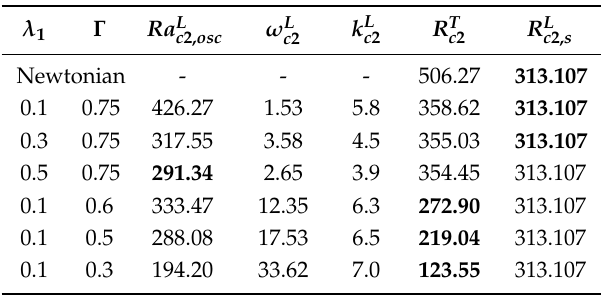
Table 3. Critical Rayleigh number Ra L longitudinal rolls as the secondary instability for different values of Γ and λ 1